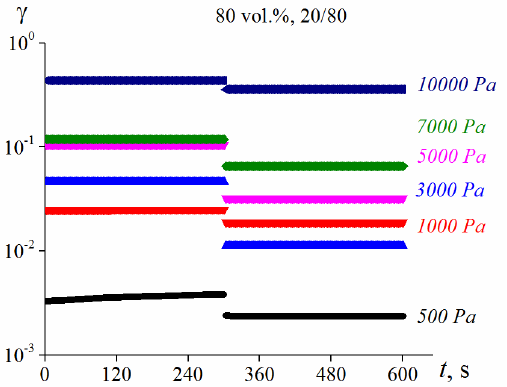
Figure 7. Development of strain and recovery at the applying constant shear stress and its relaxation for the 80 vol. % suspension ( λ = 2.4) with a 20% content of smaller particles. Stresses are shown in the Figure.